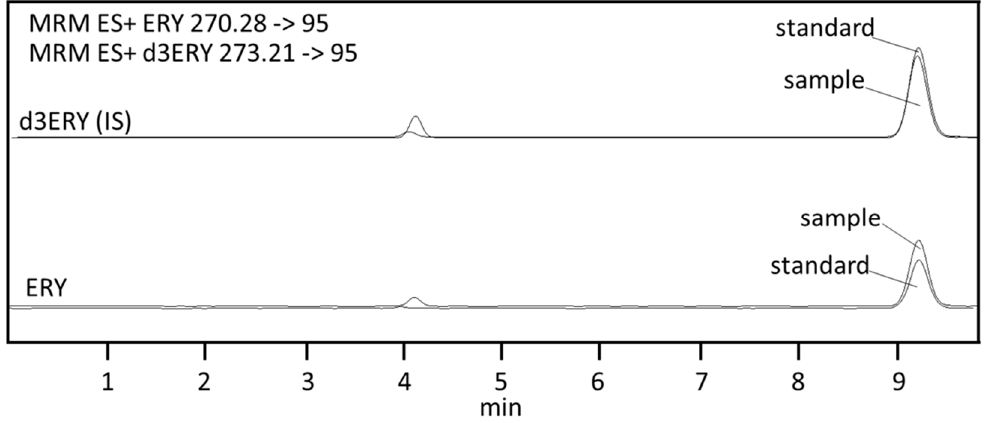
Figure 1. Representative chromatograms of a real whole blood sample (sample) and a 100 nmol/L standard. Solution of ERY (standard). ERY and d3ERY refer to the derivatized forms.